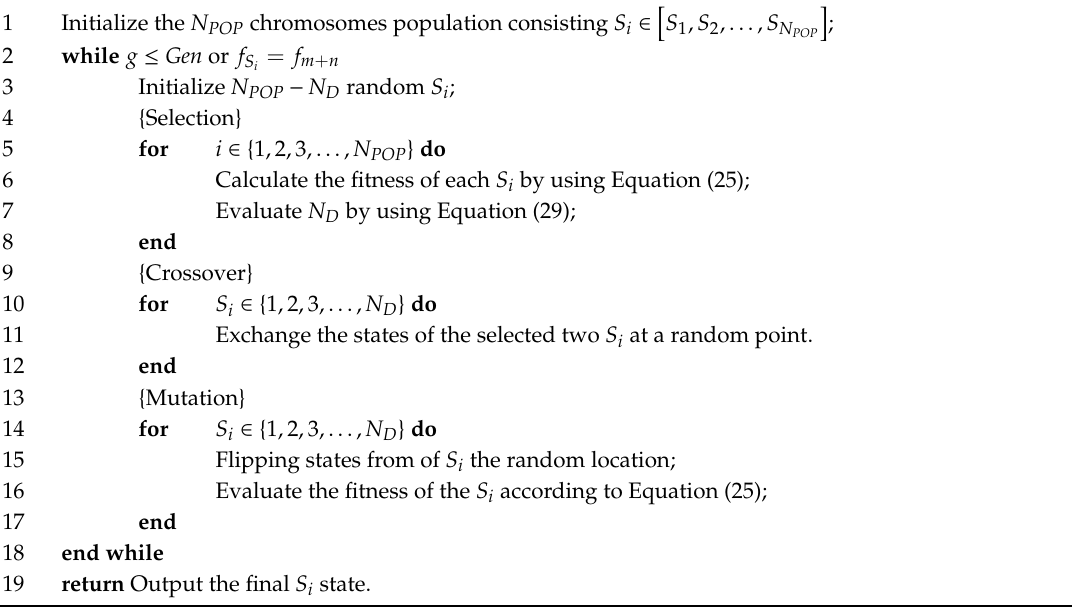
Algorithm 2 Detailed Procedure of the Proposed